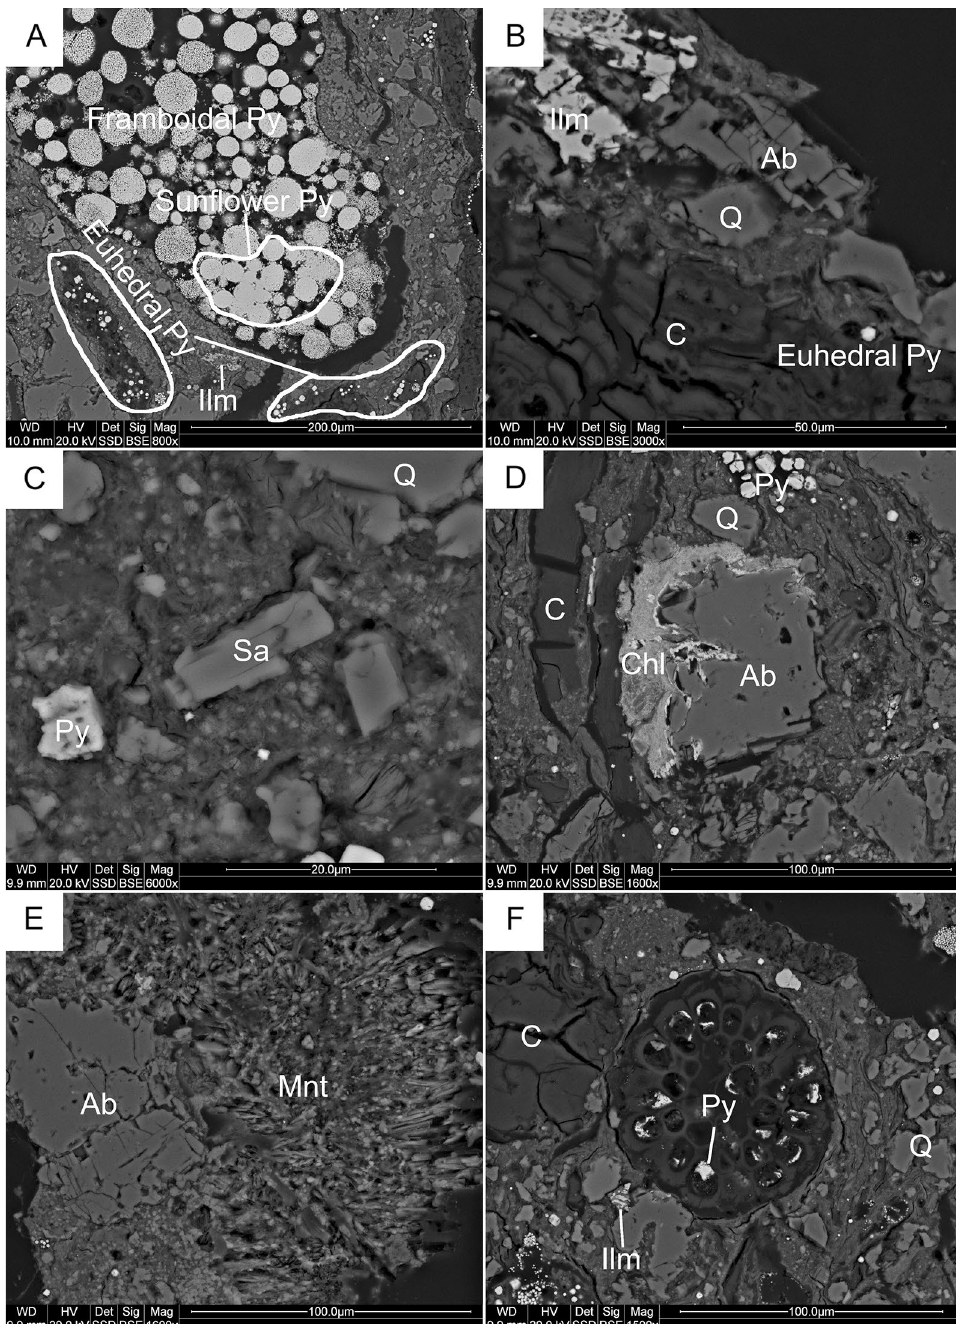
Figure 6. Thin-section scanning electron backscatter photomicrographs (SC4 sample). ( A ) The morphologies and arrangements of pyrite (Py) and iron–titanium oxides (Ilmenite—Ilm); ( B ) Albite (Ab) partially replaced by ilmenite (Ilm) and additionally euhedral pyrite (Py) grains and coalified plant detritus lamina; ( C ) Sanidine (Sa), detrital pyrite (Py) and quartz (Q) grains; ( D ) Partially chloritized (Chl) albite (Ab) grain with quartz (Q), euhedral pyrite (Py) and coalified plant detritus lamina; ( E ) Albite (Ab) partially replaced by Ca–Mg smectite (montmorillonite—Mnt); ( F ) The cross section of pollen with syngenetic pyrite (Py) inside